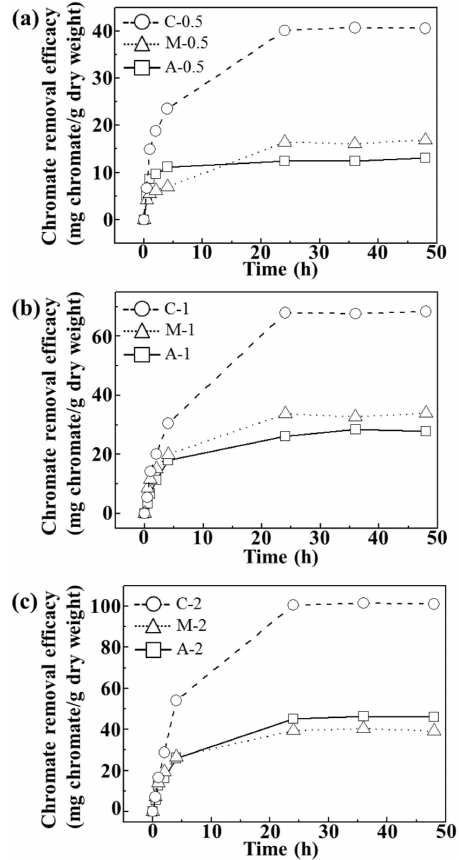
Figure 4. Time-dependent chromate removal efficacy (mg chromate/g dry weight) of agarose only (A), LDH-agarose mixture (M) and LDH-agarose composite (C) samples for ( a ) 0.5 wt/v%; ( b ) 1 wt/v%; and ( c ) 2 wt/v% agarose-based materials. The experiments were carried out at initial chromate concentration of 400 ppm and at pH